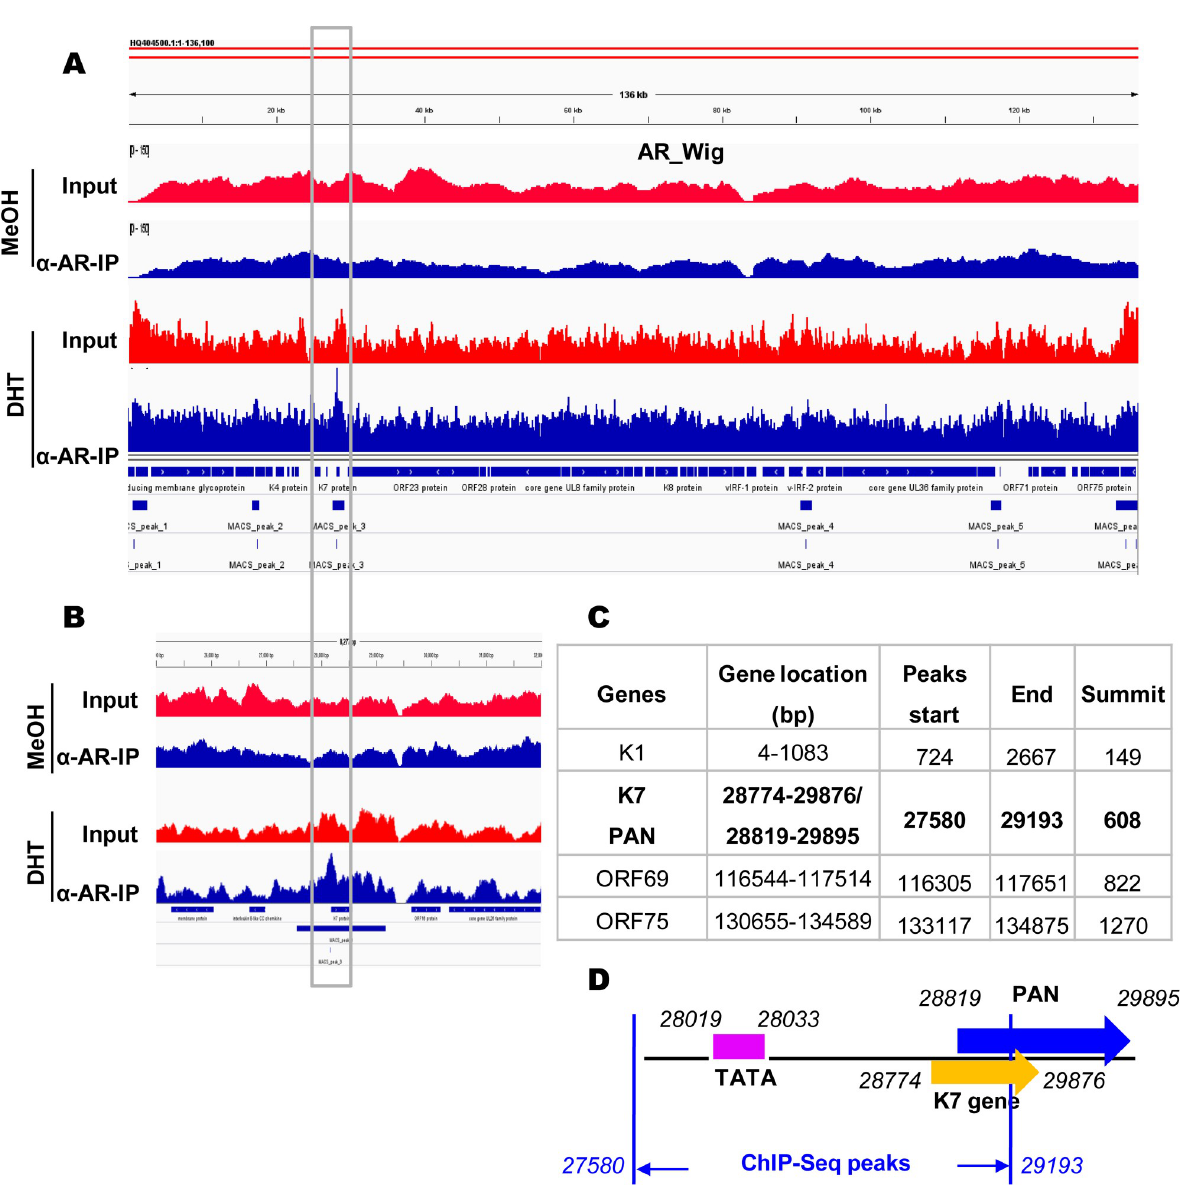
Fig 2. AR had multiple co-occupation sites on the KSHV genome. (A) Illustration of the binding sites by the AR on the whole KSHV genome upon DHT treatment or solvent control. The ChIP-seq data on the AR were aligned to the KSHV genome (HQ404500) and subjected to peak calling with MACS ( P < 10 − 3 ). The output files were visualized in IGV software. The summit diagrams showed the sites with the highest scores in the peaks. The wig diagrams showed the general binding information for the whole KSHV genome. (B) Enlarged regions covering peaks 1, 2, and 3 from (A). The most significant peaks representing AR-binding sites upon DHT treatment were concentrated in the PAN/K7 region; smaller peaks were scattered throughout the genome. (C) Annotated information on the AR peaks ( P < 10 − 3 ) throughout the KSHV genome is shown. (D) Schematic information on the PAN gene, which partially overlapped with the K7